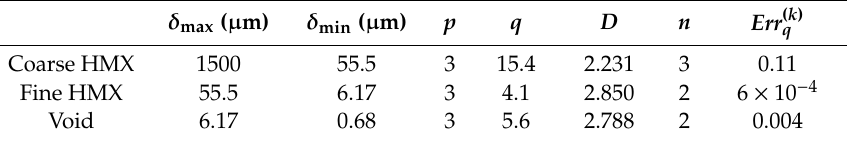
Table 2. The parameters in the NU model of the PBX